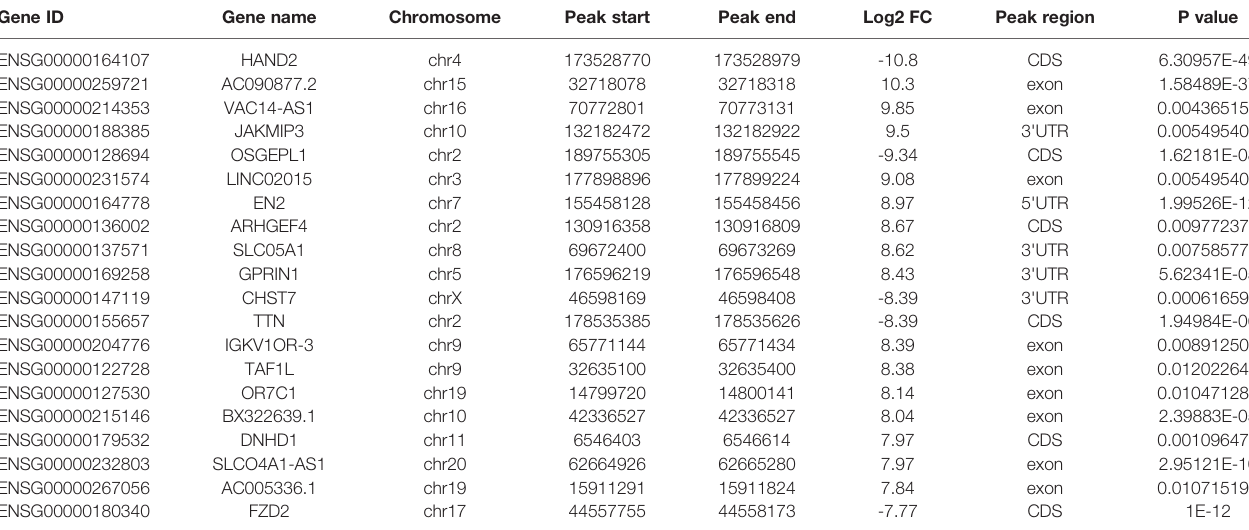
TABLE 1 | Top 20 differently methylated m6A peaks in Tumor vs Normal.